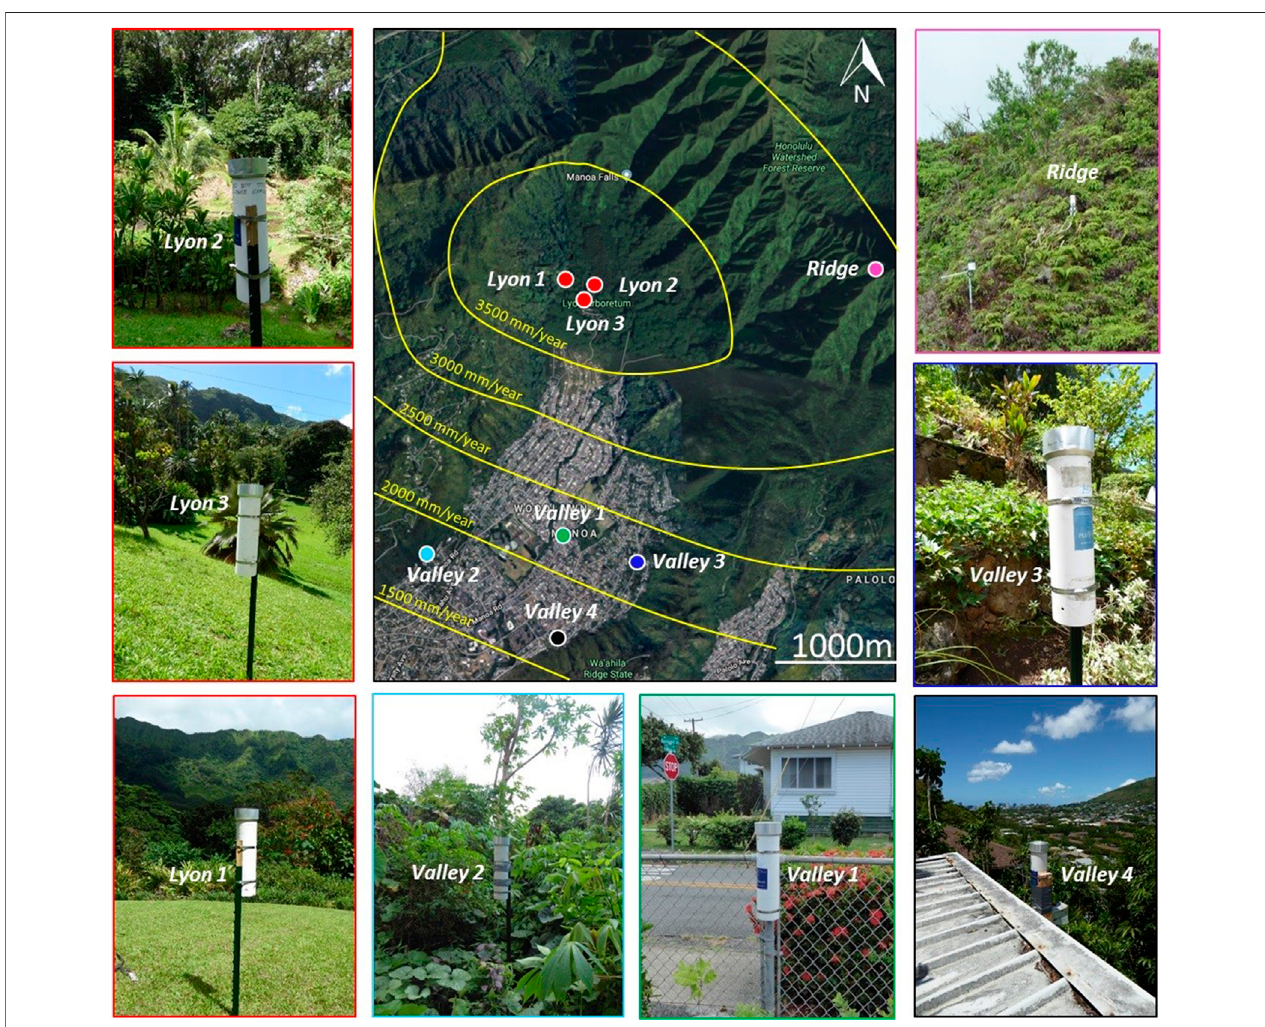
FIGURE2| RaingaugesinM (cid:1) anoaValley.Themapinthecentralpanel(Mapdata © 2020:GoogleEarth,MaxarTechnologies,Landsat,Copernicus)displaysgauge locationsaswellasthelocalmeanannualrainfallclimatologyinmm/year(Giambellucaetal.,2013).Outerpanelsshowtheset-upofeachraingauge.Thecolorofpicture borders links the pictures with the gauge location in the central panel.